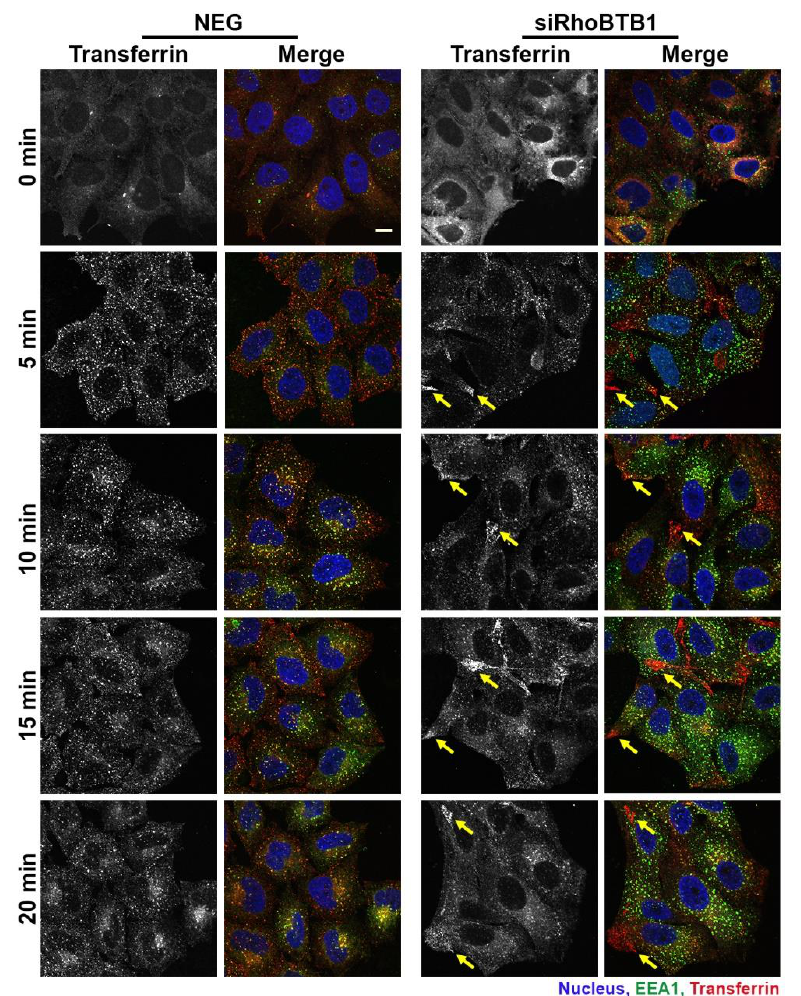
Figure 7. Depletion of RhoBTB1 alters Transferrin-Alexa Fluor 568 trafficking in HeLa Kyoto cells. Representative images of the effect of RhoBTB1 depletion on Tf-Alexa Fluor 568 uptake in HeLa Kyoto cells compared with control NEG siRNA-treated cells. Cells were incubated on ice for 30 min with transferrin (red) before being warmed to 37 °C to allow internalisation to start. Cells were fixed at the times indicated and immunostained for EEA1 (green) and stained for the nuclei (blue). Yellow arrows indicate peripheral accumulations of Tf. Bar represents 10 μm.